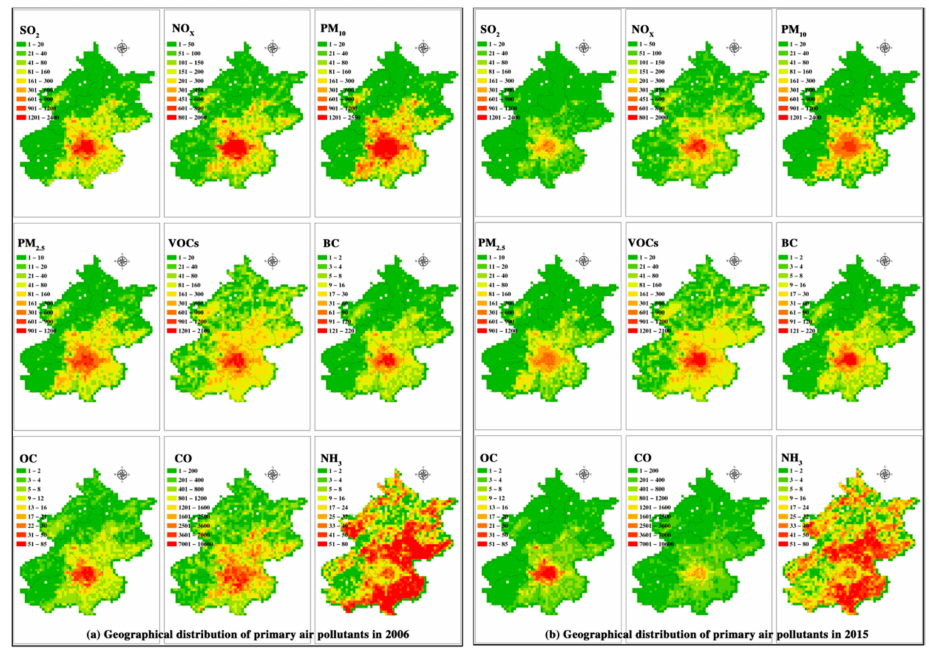
Figure 5. Geographical distribution of primary air pollutants in 2006 and 2015,